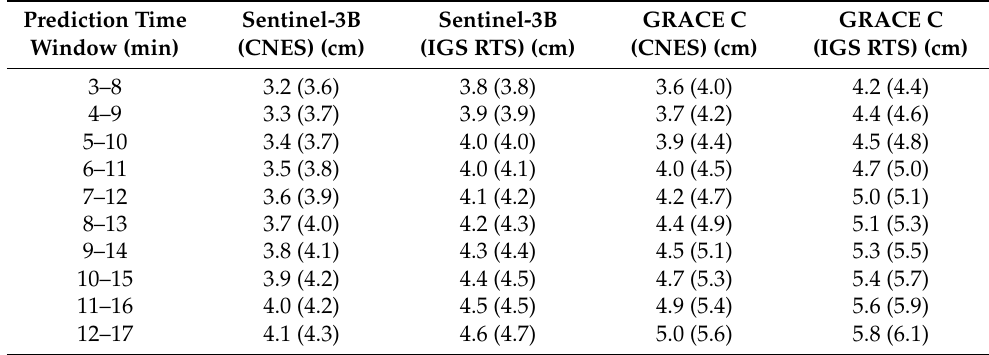
Table 8. Averaged OURE of the predicted orbits within different prediction time windows. The results without outlier exclusions are given in parentheses.